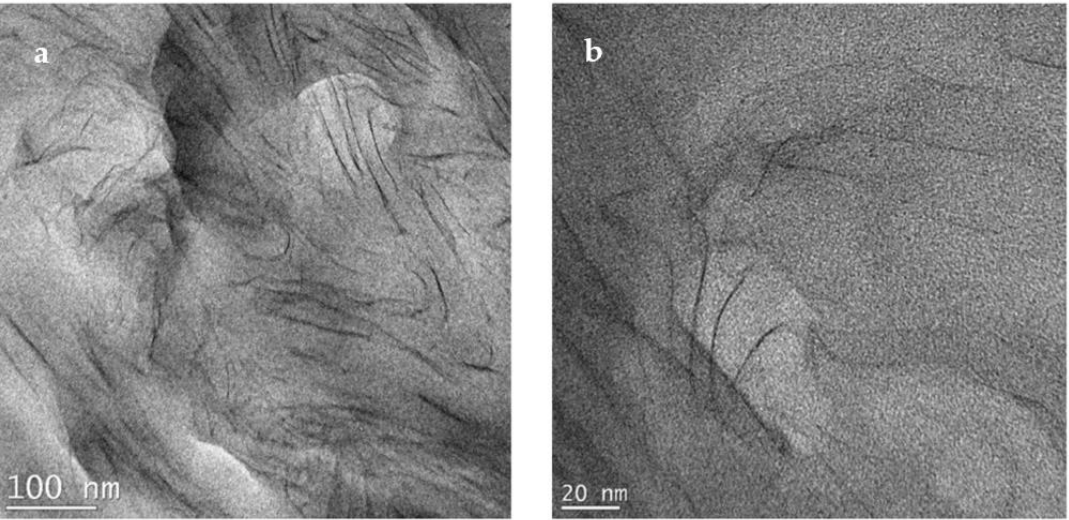
Figure 9. TEM micrographs for N6-15A prepared by solution compounding at low ( a ) and high ( b ) magnifications.